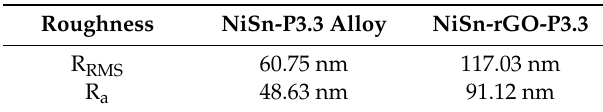
Table 4. Statistical roughness quantities calculated for the 2D topography image (10 × 10 µ m 2 ) for